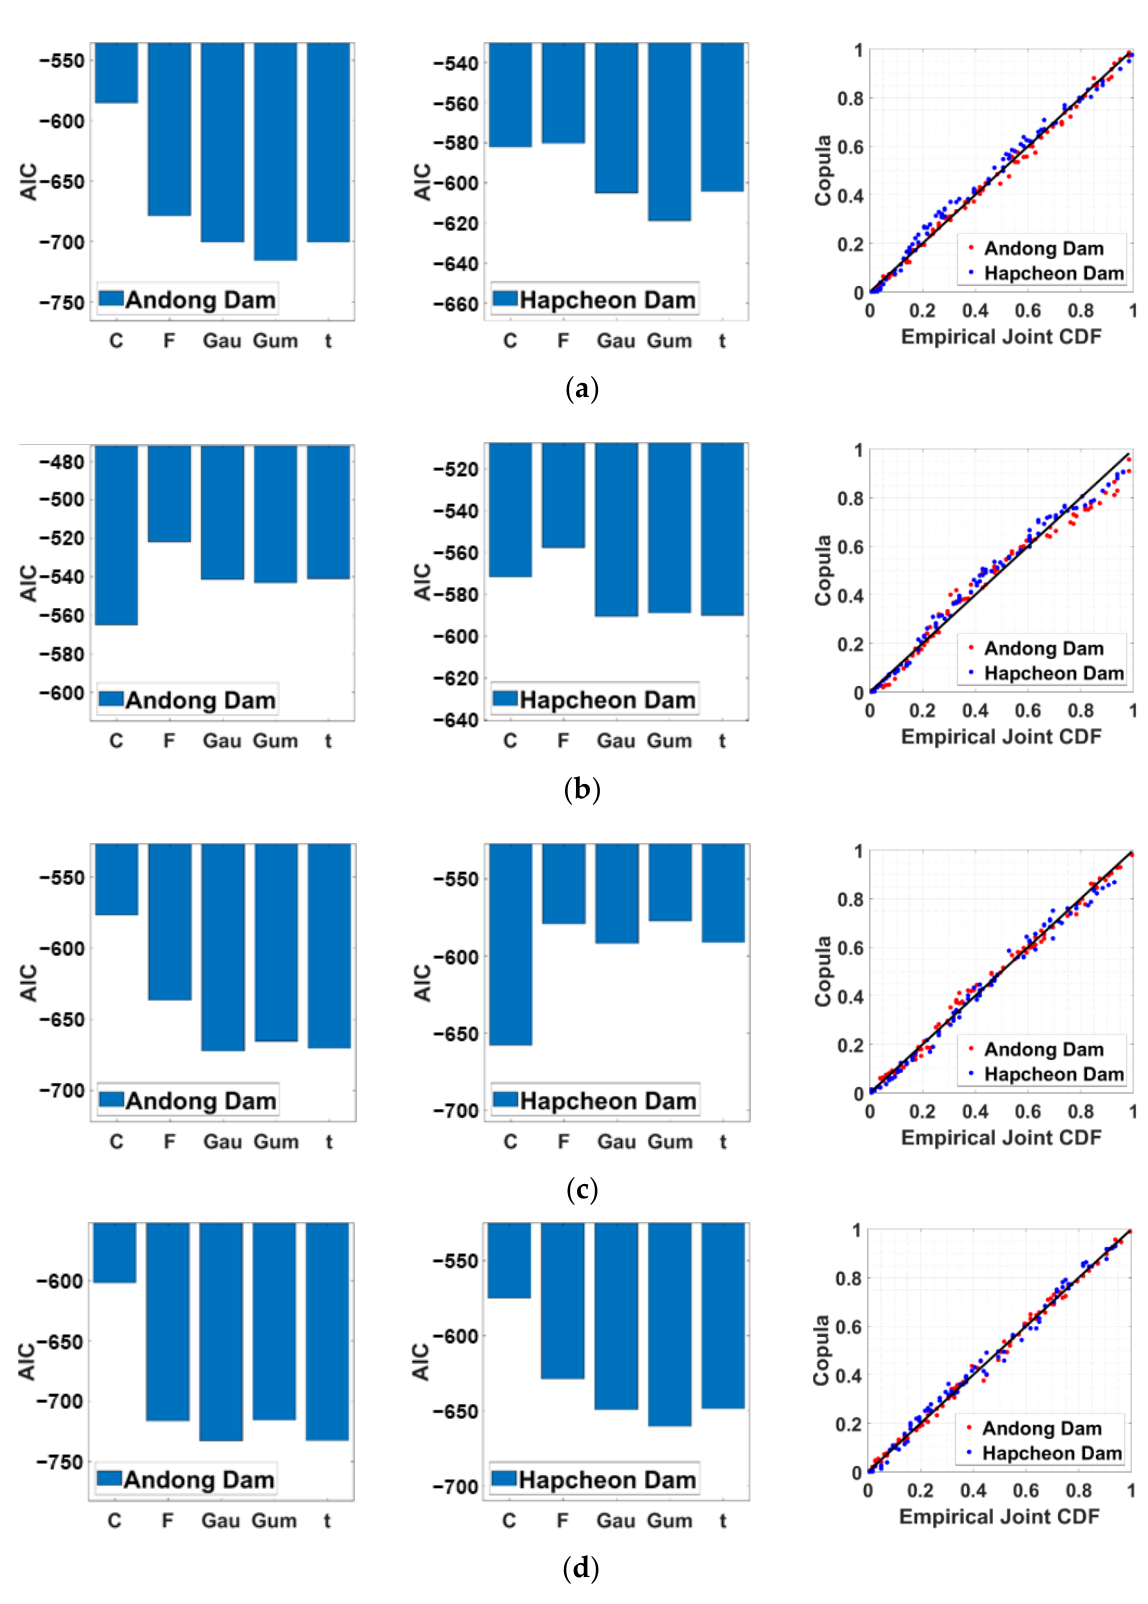
Figure 7. AIC values of five copulas (C, F, Gau, Gum, and t indicate Clayton, Frank, Gumbel, Gaussian, and Student’s t copula, respectively) and Q–Q plot of optimal copula (SPI–SMI): ( a ) spring; ( b ) summer; ( c ) fall; ( d ) winter.